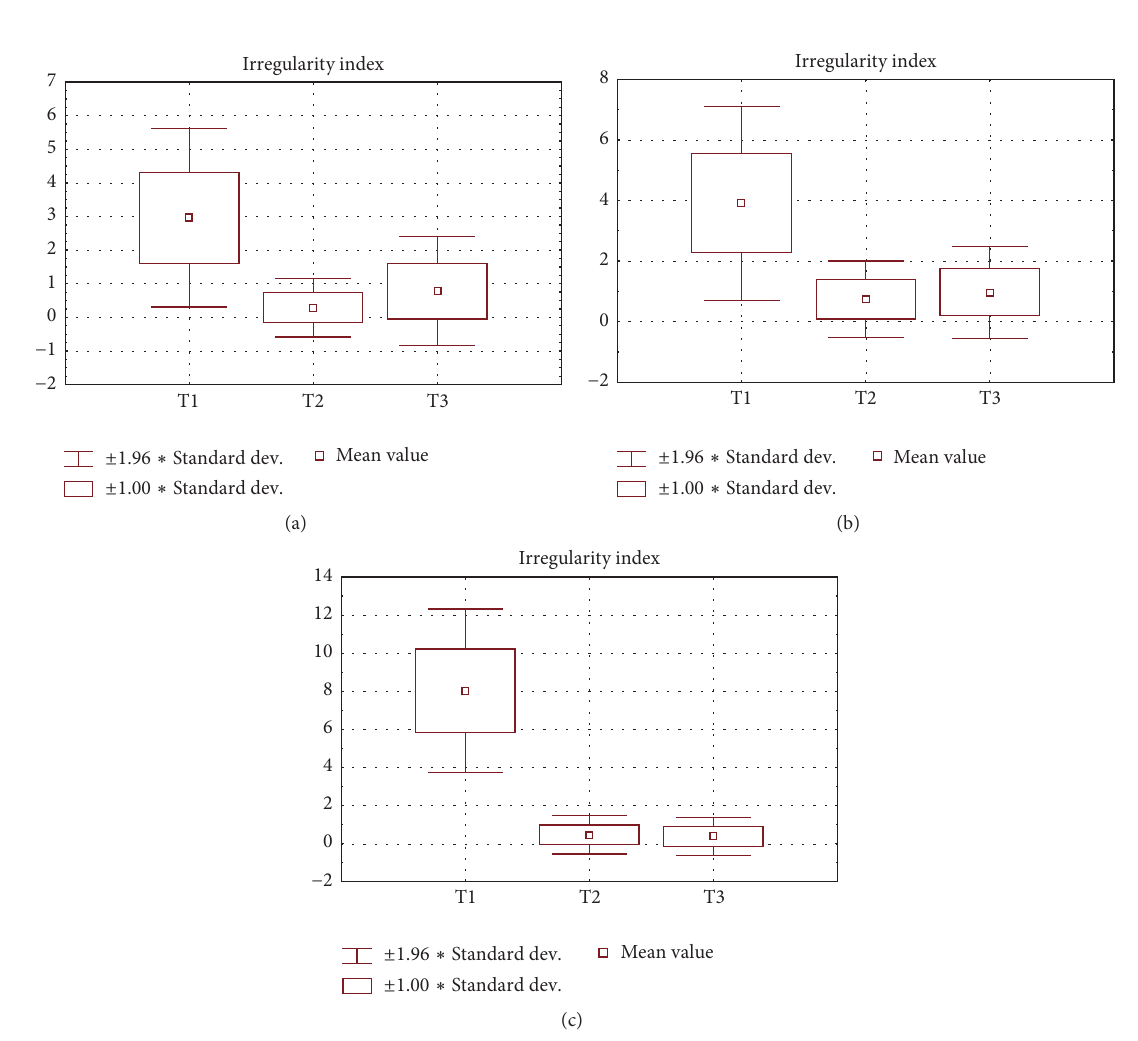
Figure 2: Results of statistic analysis of Little’s Irregularity Index values in (a) group 1, (b) group 2, and (c) group 3.